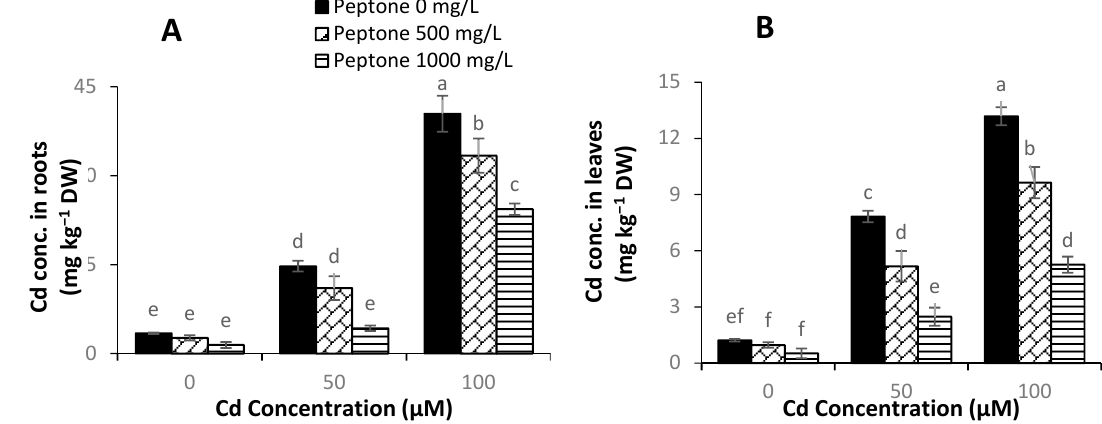
Figure 7. The influence of the foliar application of peptone (0, 500, and 1000 mgL − 1 ) on Cd concentration in roots ( A ) and Cd concentration in leaves ( B ) of spinach plants grown under Cd stress. Values represent the means of four replicates with standard deviations. Letters on the bar indicate the significant di ff erences between given treatments at p <